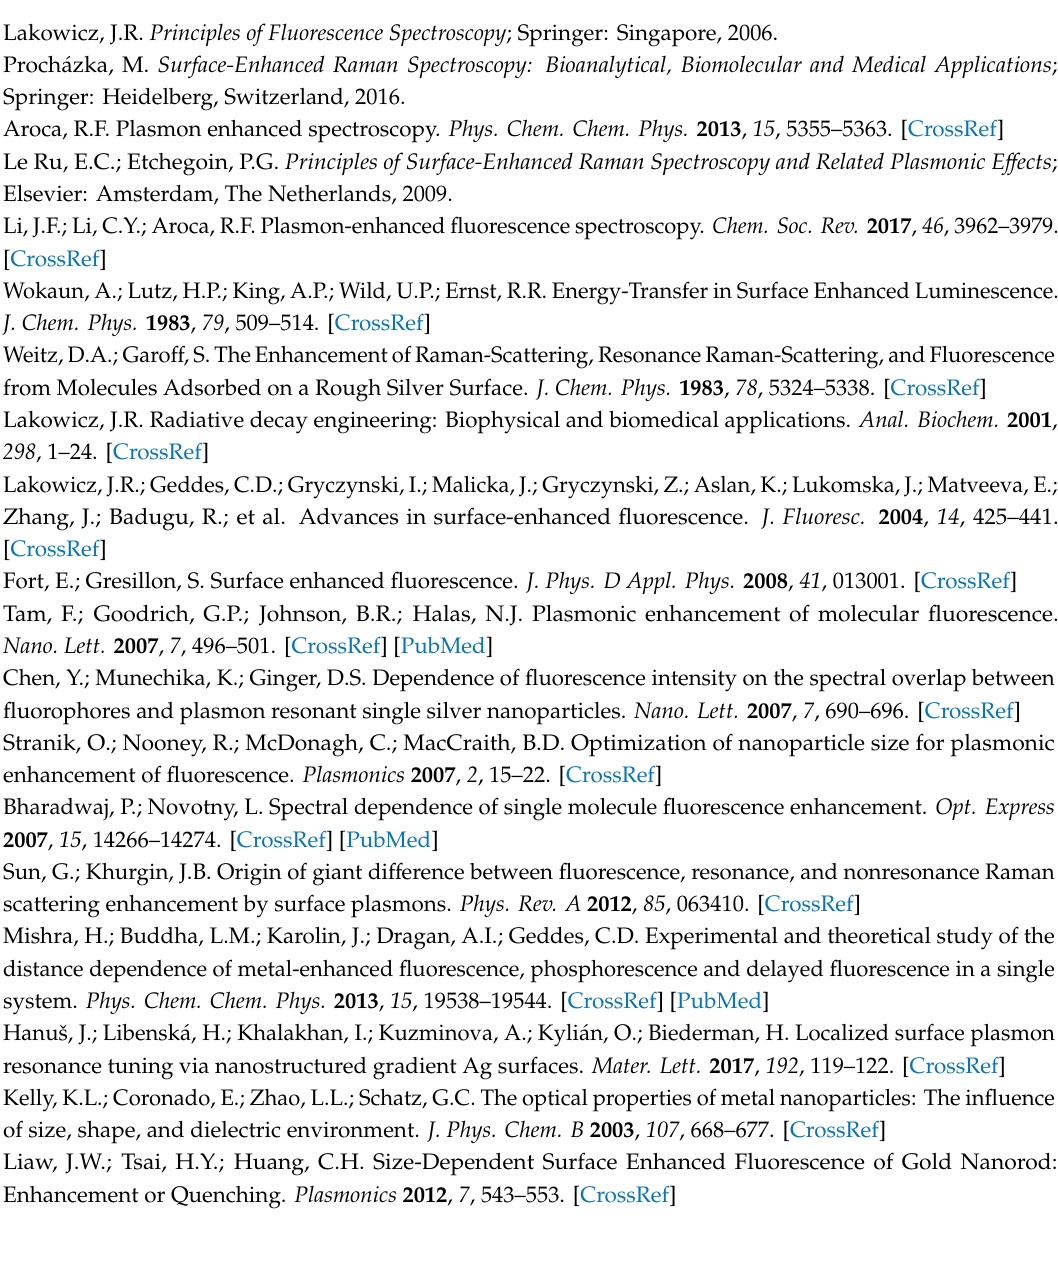
Figure S1: Simplified block diagram of the fluorescence microspectrofluorimeter, Figure S2: The sessile droplet geometry, Figure S3: Dependence of the fluorescence signal on the droplet geometry, Figure S4: Focus position inside the droplet, Figure S5: Geometry of the